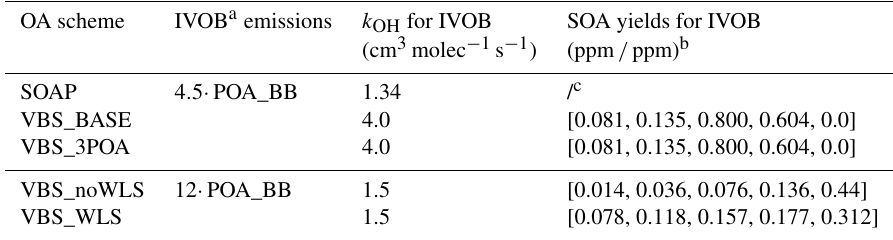
Table 1. Description of the different OA